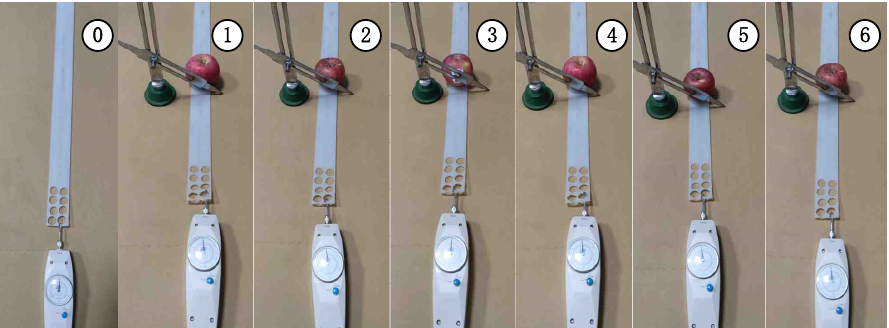
Figure 7. Friction test between suction cup silica gel material and Fuji apple surface. The steps are as follows: Cut the silica gel into 500 mm × 50 mm strips with a thickness of 10 mm and spread them on the experimental platform. (1) Drag the sample to slide on the experimental platform with a tension meter, record the number of the